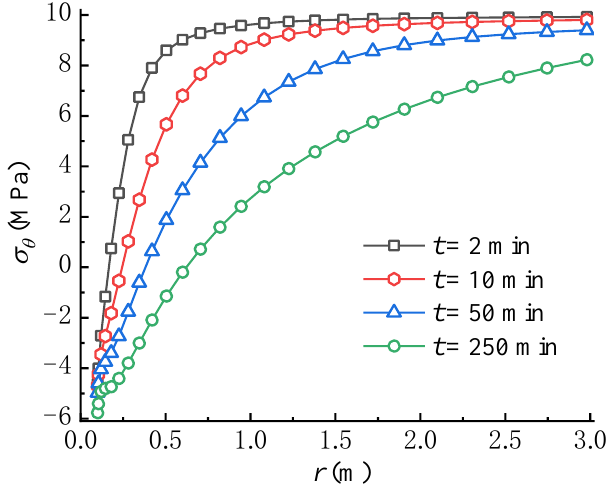
Figure 9. Variation of σ θ with time ( p w = 20 MPa).